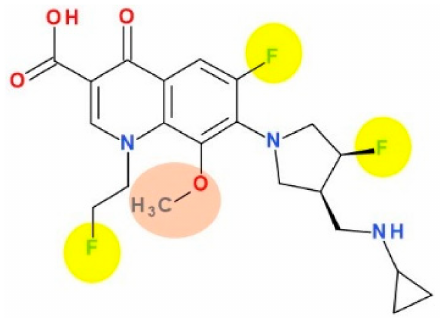
Figure 8. Chemical structure of lascufloxacin. Table 6. Physicochemical properties of lascufloxacin.